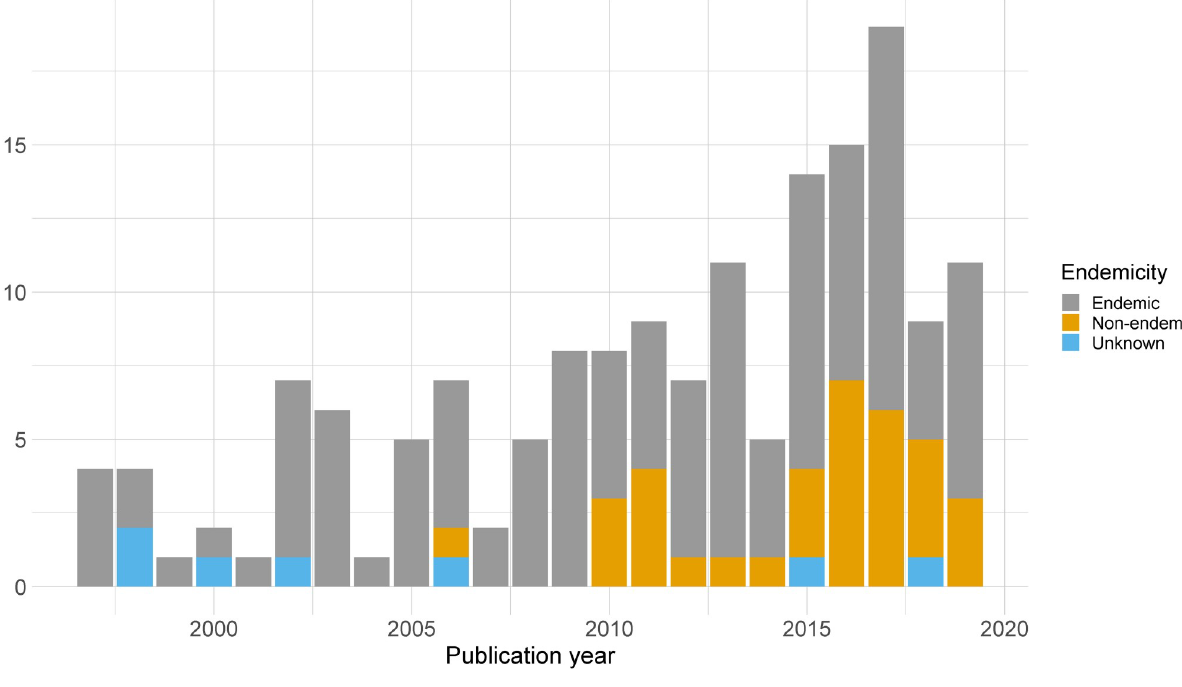
Fig 3. Temporal distribution of cohort